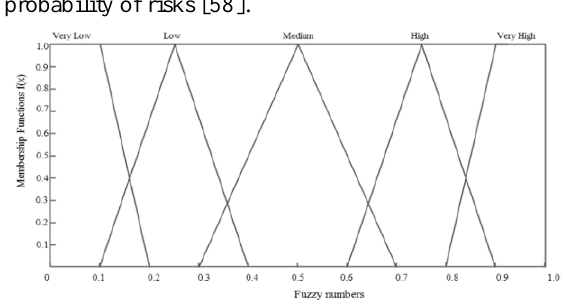
Figure 3. Linguistic values of fuzzy